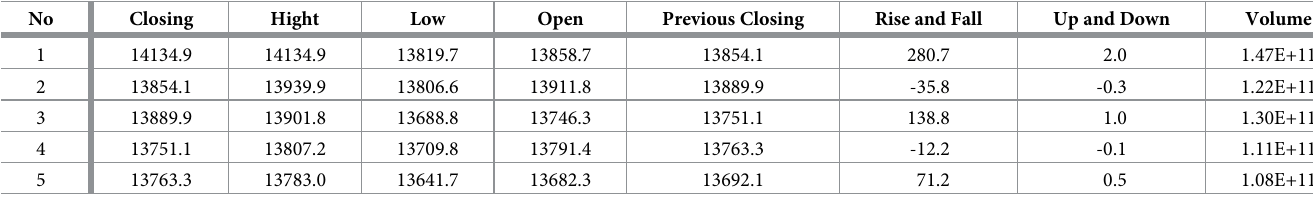
Table 1. Some data of Shenzhen Composite